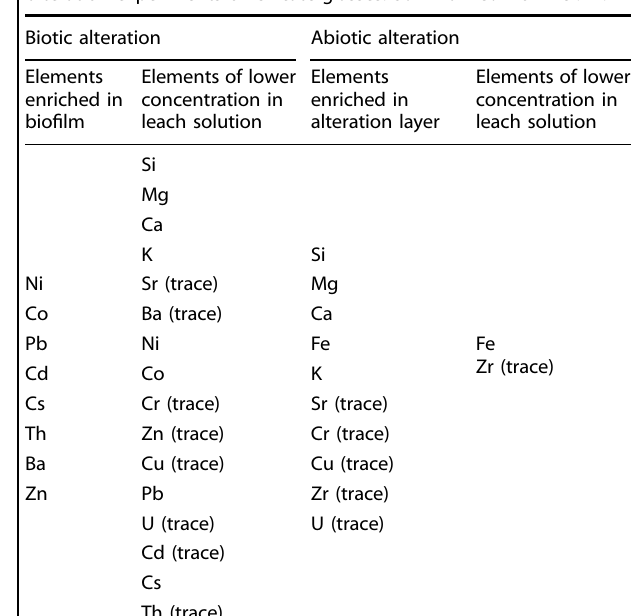
Table 2. Summary of leached elements for biotic and abiotic glass alteration experiments on silicate glasses. Summarized from ref. 14